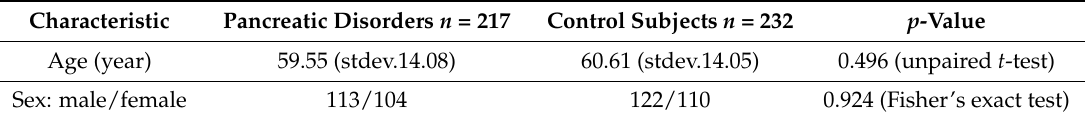
Table 1. Demographic characteristics of the patients